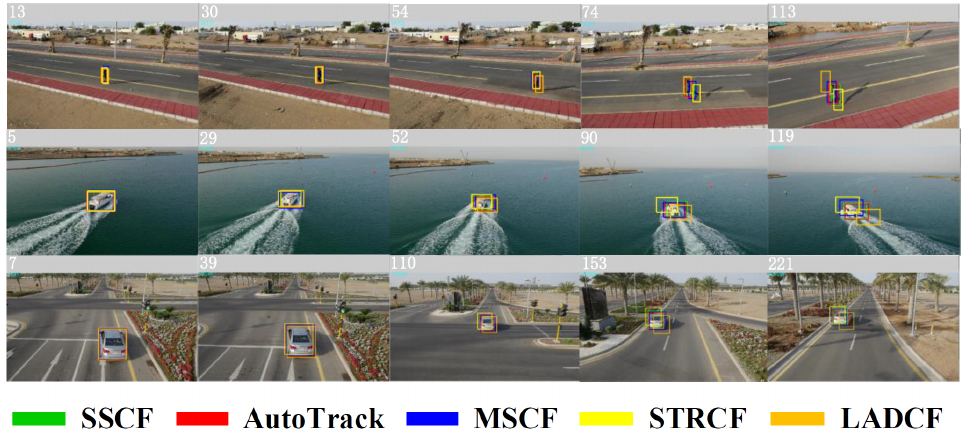
Figure 7. The qualitative analysis of different trackers on three video sequences.